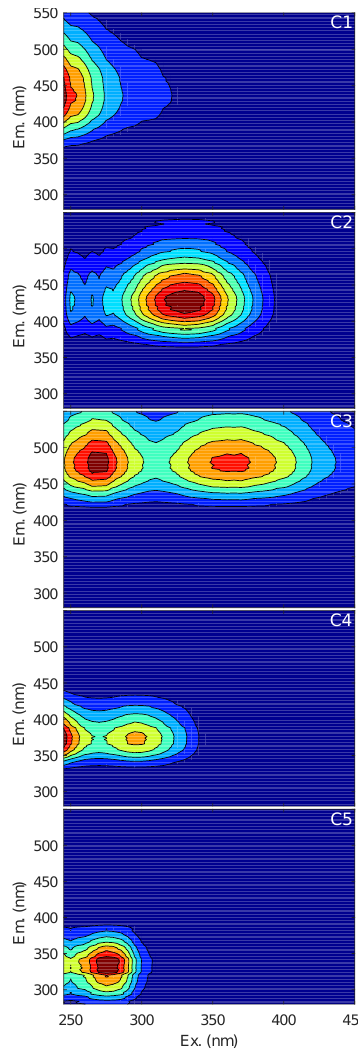
Figure 4. Spectral properties of the five PARAFAC components (C1–C5) found in this study. The x axis shows the excitation (Ex) wavelength in nanometres (nm) and the y axis shows the emission (Em) wavelength in nanometres (nm) with low fluorescence being blue and high being